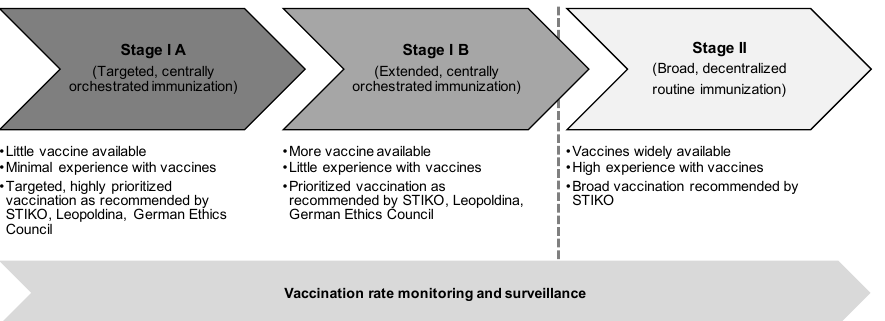
Figure 1. Immunization stages defined by the “National Vaccination Strategy COVID-19” (based on